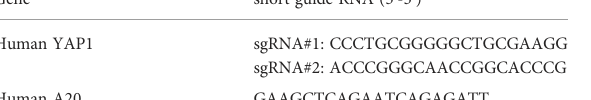
TABLE 6 Short guide RNAs (sgRNAs). Gene short guide RNA (5 ’ -3 ’ )